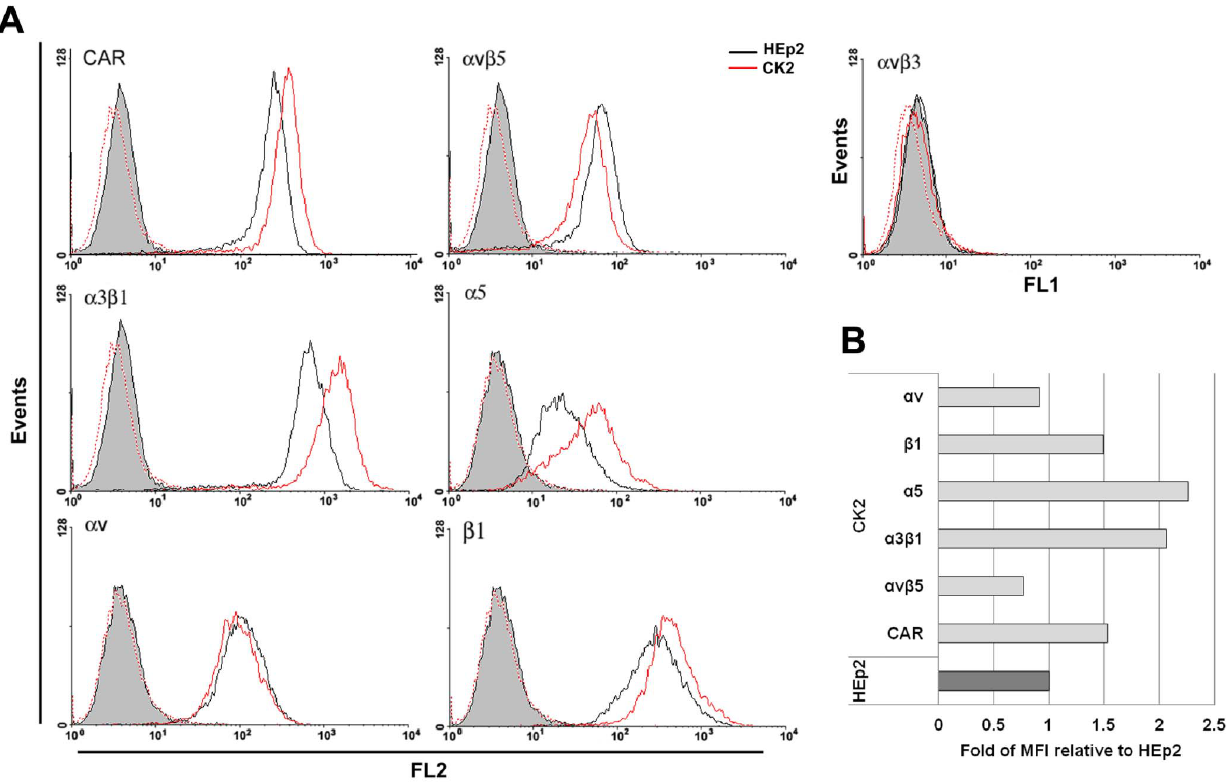
Figure 1. Cell surface levels of CAR, integrin heterodimers a v b 3, a v b 5 and a 3 b 1, integrin subunits a 5, a v and b 1 on HEp2 and CK2 cells. Cells were detached by Versene and incubated with murine monoclonal antibodies or isotype-matched antibody as a negative control. After incubation with the secondary reagent (i.e. PE-conjugated anti-mouse antibody), labeled cells were analyzed by flow cytometry. (A). Representative histograms and (B) mean fluorescence intensities relative to HEp2 cells obtained in one of three independent experiments that provided similar results are shown.